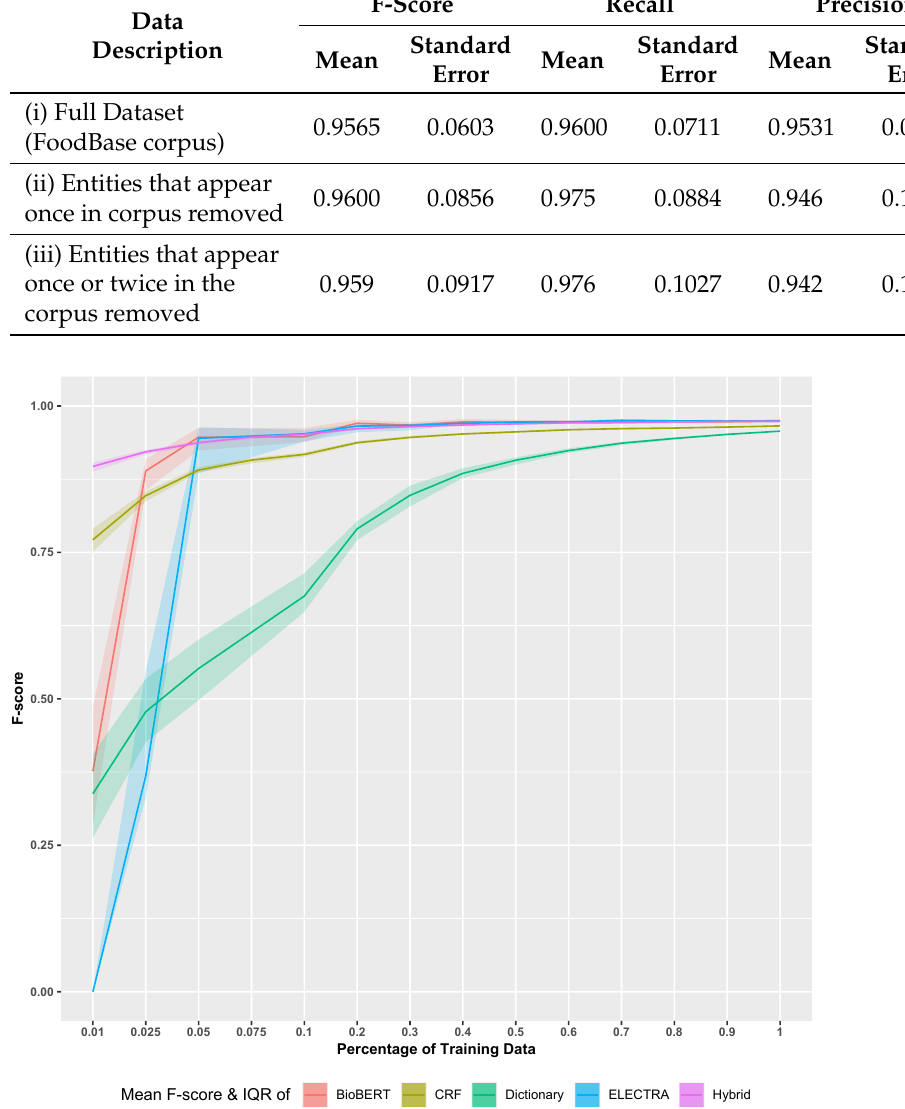
Figure 4. Learning curves based on F-score for the dictionary model, CRF model, hybrid model, BioBERT model and ELECTRA model. The line represents the mean F-score, and the shaded area represents the inter-quartile range